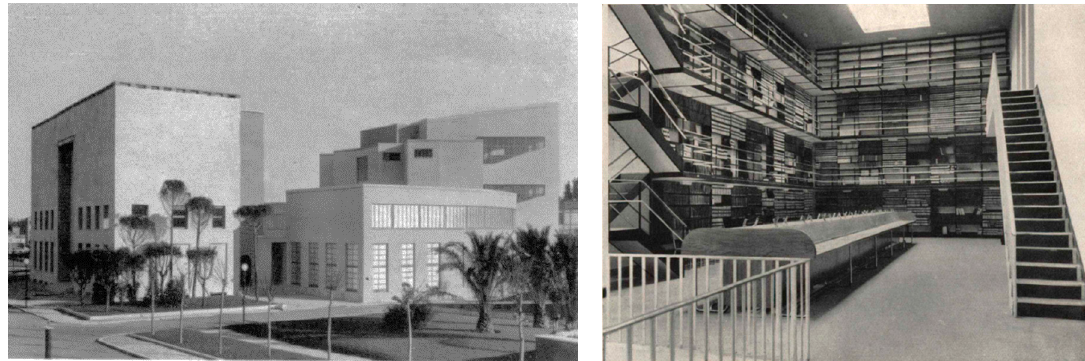
Figure 30. School of Matematics by Gio Ponti (1933–1935). Photo from (Baliviera et al. 1935, p. 45–46).